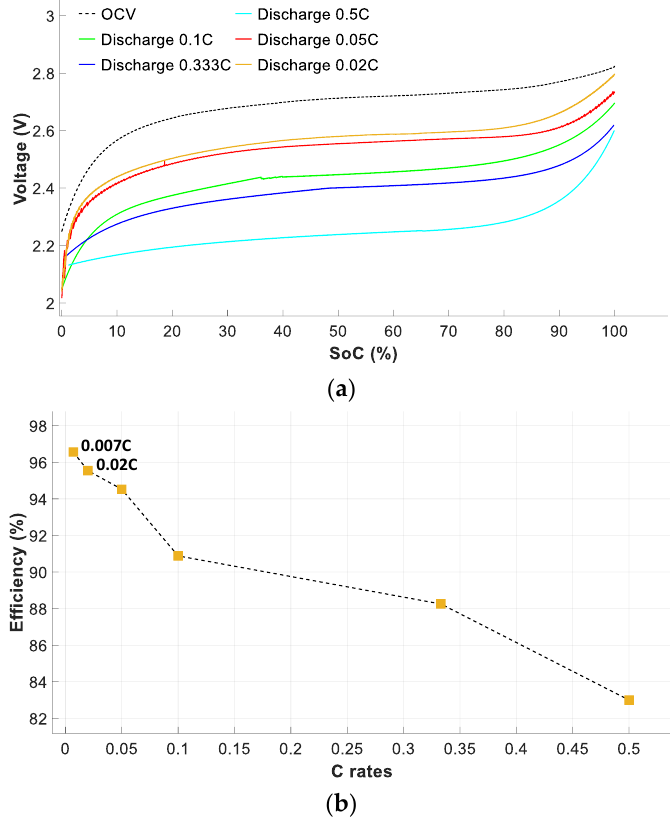
Figure 10. Battery pack performance during the discharge cycle. ( a ) Voltage curves as a function of SoC . ( b ) Battery discharge efficiencies at different current rates.